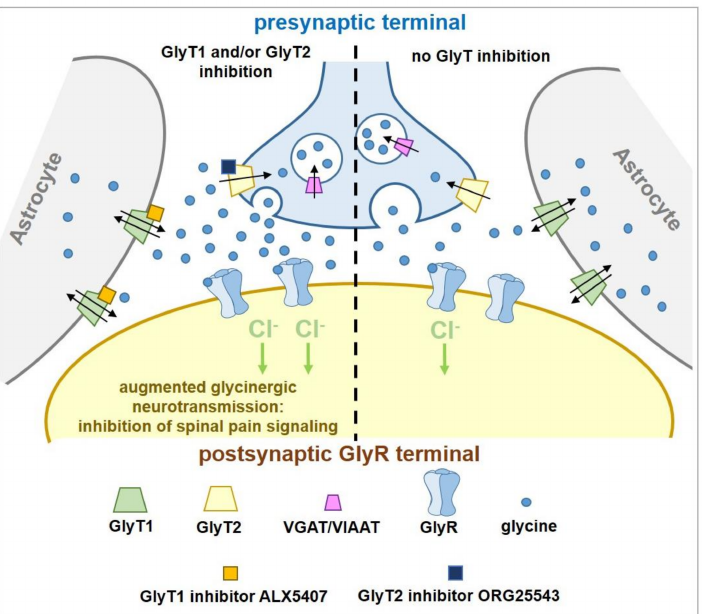
Figure 8. Potential functional consequences of dual GlyT2 inhibition at an inhibitory glycinergic synapse. Shown on the left is a putative synergistic effect of co-application of sub-analgesic doses